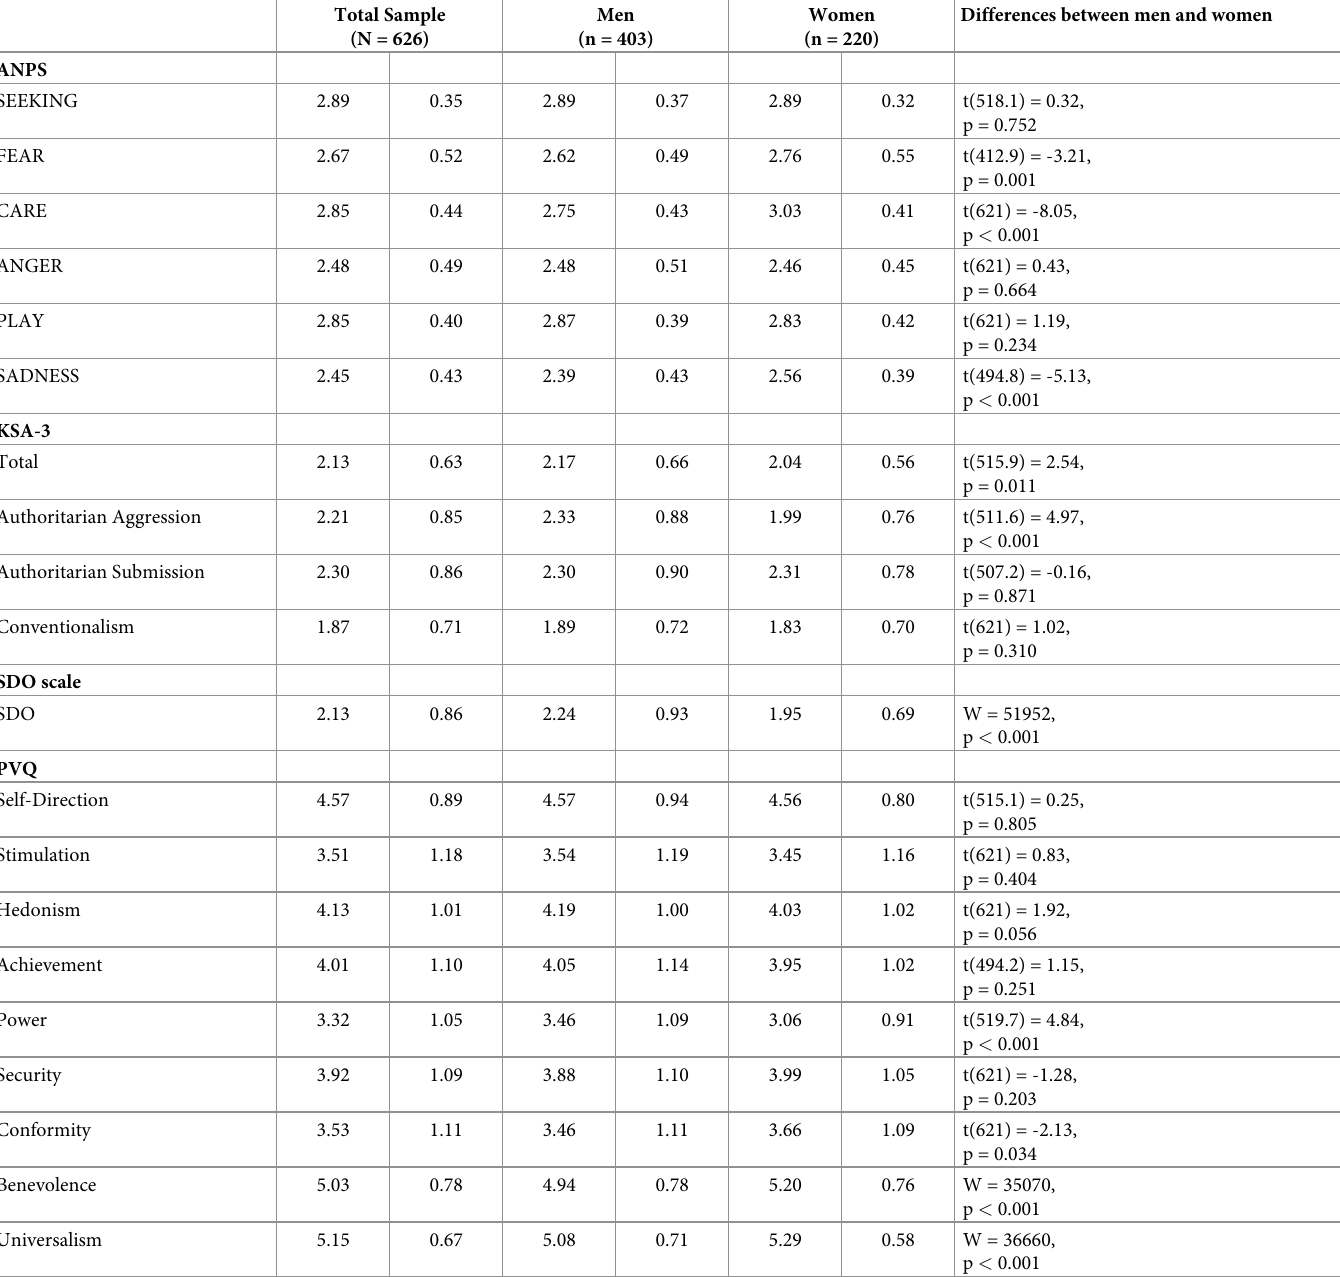
Table 1. Descriptive statistics on variables of main interest and differences between men and